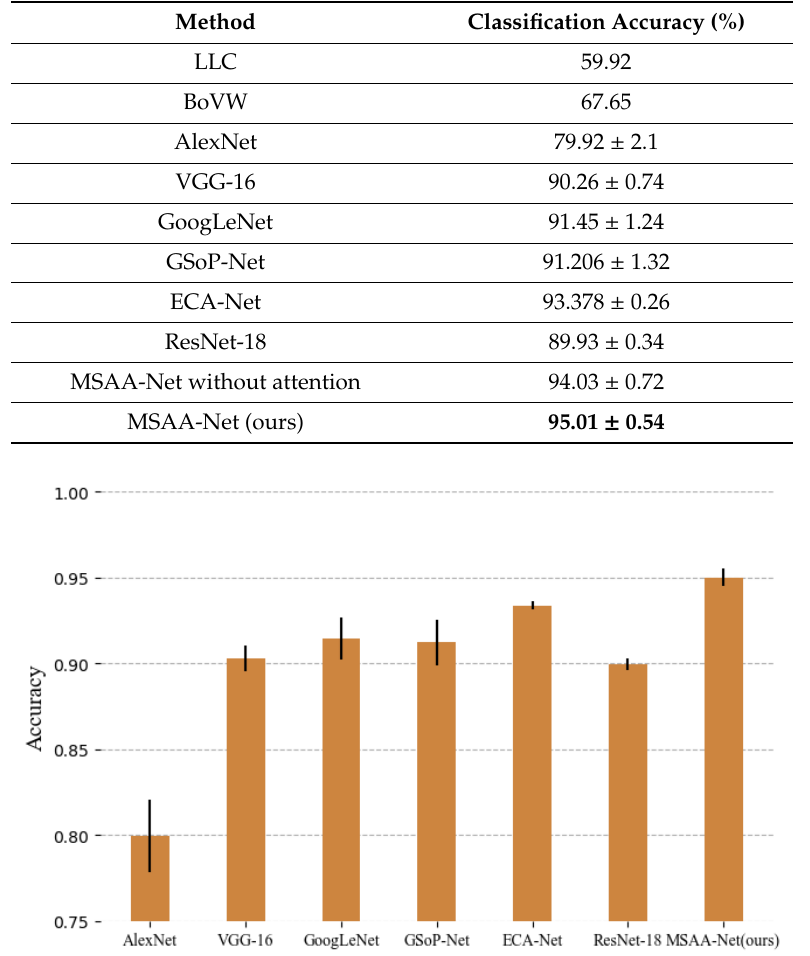
Table 2. Comparison between the previous reported accuracies with NWPU-RESISC45 dataset, with 50% training samples selected.